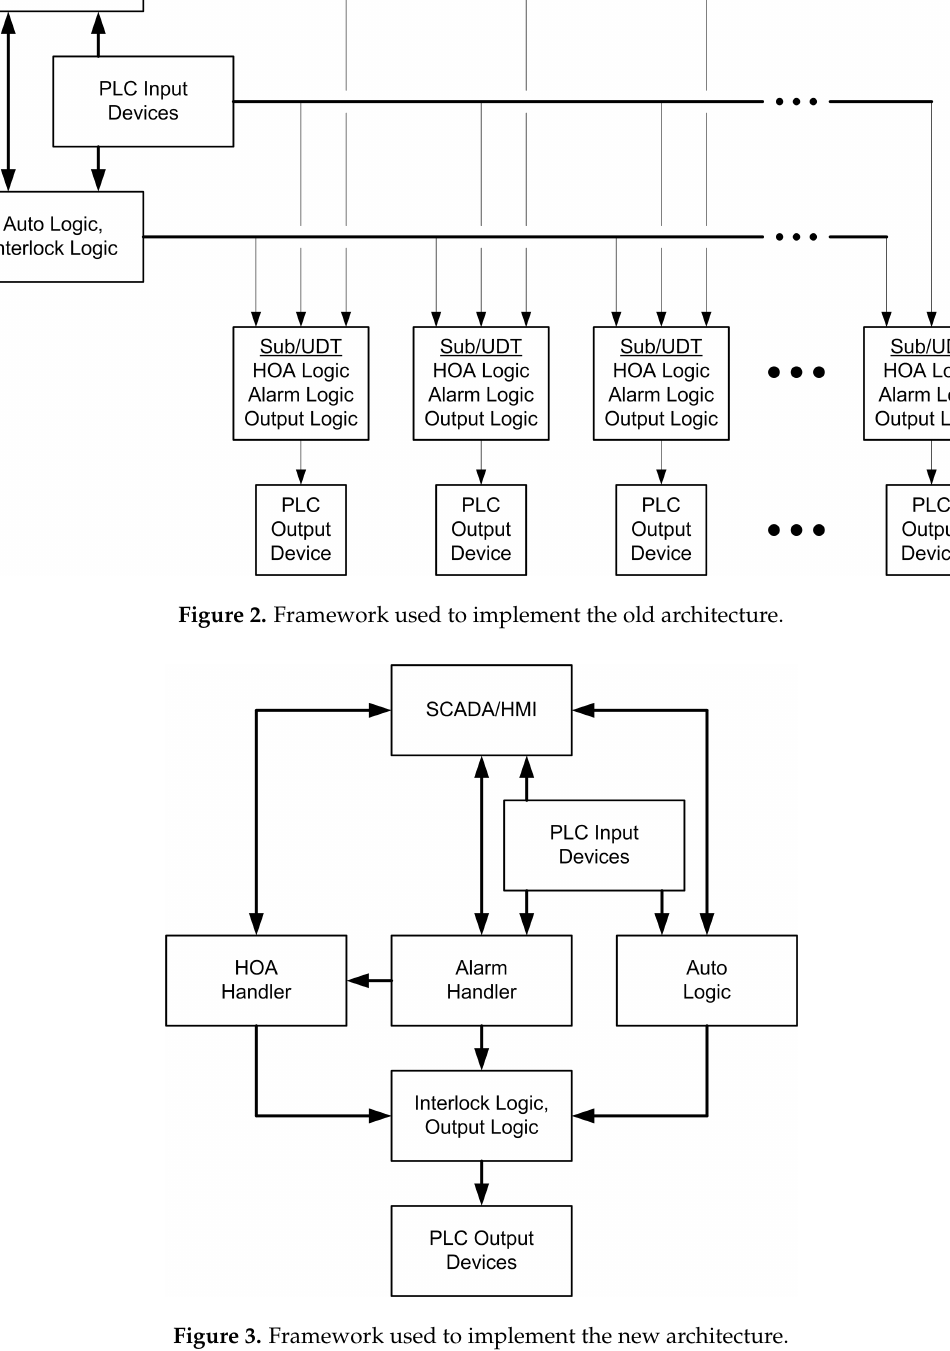
Figure 3. Framework used to implement the new